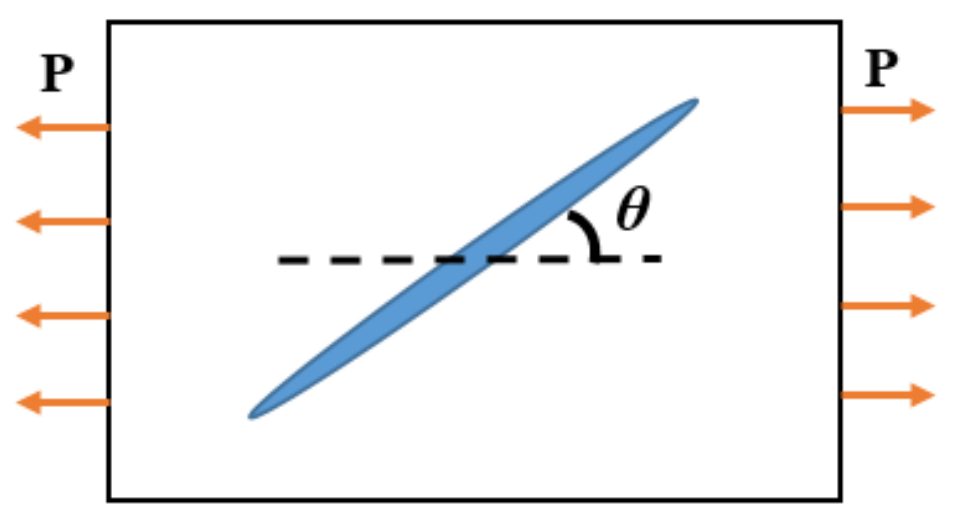
Figure 3. The mechanical model. Where: θ is the angle between fracture and the uniaxial tensile force P .